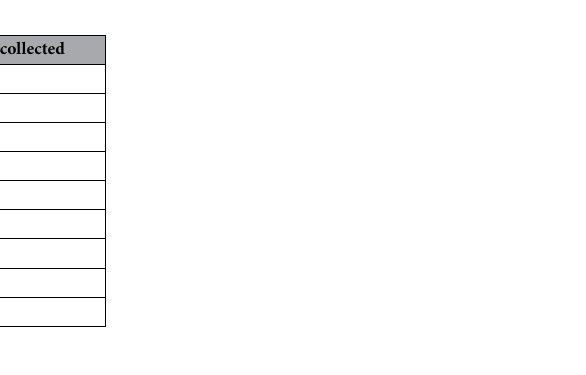
Figure 4. ML trees reconstructed using ITS ( a ) and ITS + trnH - psbA ( b ). Numbers are bootstrap values, branches with the bootstrap value < 50% are collapsed. Both phylogenies show the lack of resolution among Echinacea species using either combination of genes.